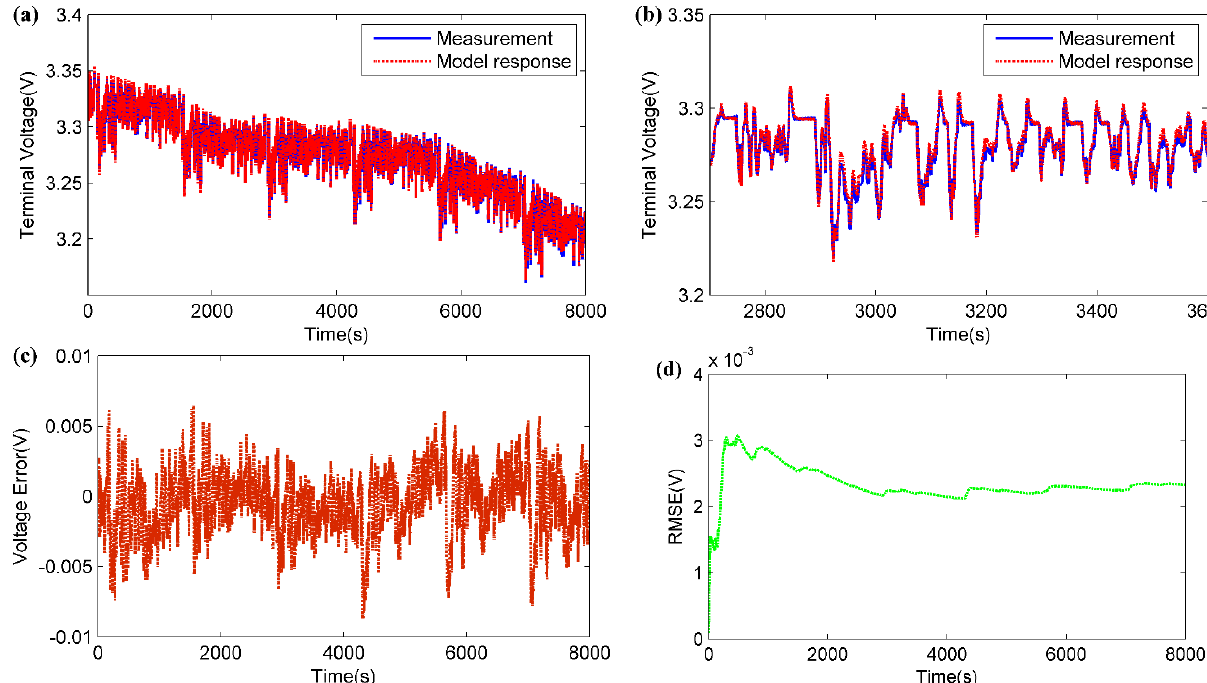
Figure 7. Model validation results of LFP cell: ( a ) Comparison of model output voltage and measured voltage; ( b ) Zoom plot; ( c ) Voltage error; ( d ) RMSE of voltage